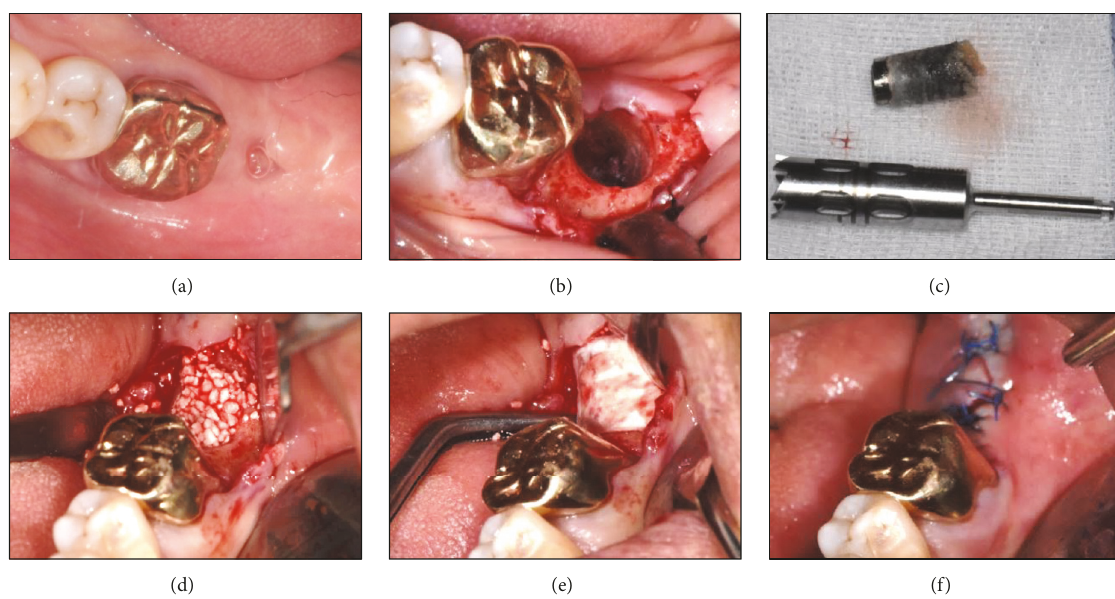
Figure 2: Conventional removal method applied on #37 region. (a) Preoperative state showing a gingival defect. (b) Implant removal using a trephine bur (external diameter: 6 mm, internal diameter: 5 mm; Biomet, Warsaw, IN, USA), elevator (Hu-Friedy, Chicago, IL, USA), and root forceps (Hu-Friedy, Chicago, IL, USA). (c) The implant and the surrounding alveolar bone removal. ((d) and (e)) Immediate bone grafting [Osteon II 0.5 g (particle size 0.5 ∼ 1.0 mm) and collagen membrane 15 × 20 mm; Genoss, Suwon, Korea] on the implant removal socket. (f) Suture for a primary wound closure.